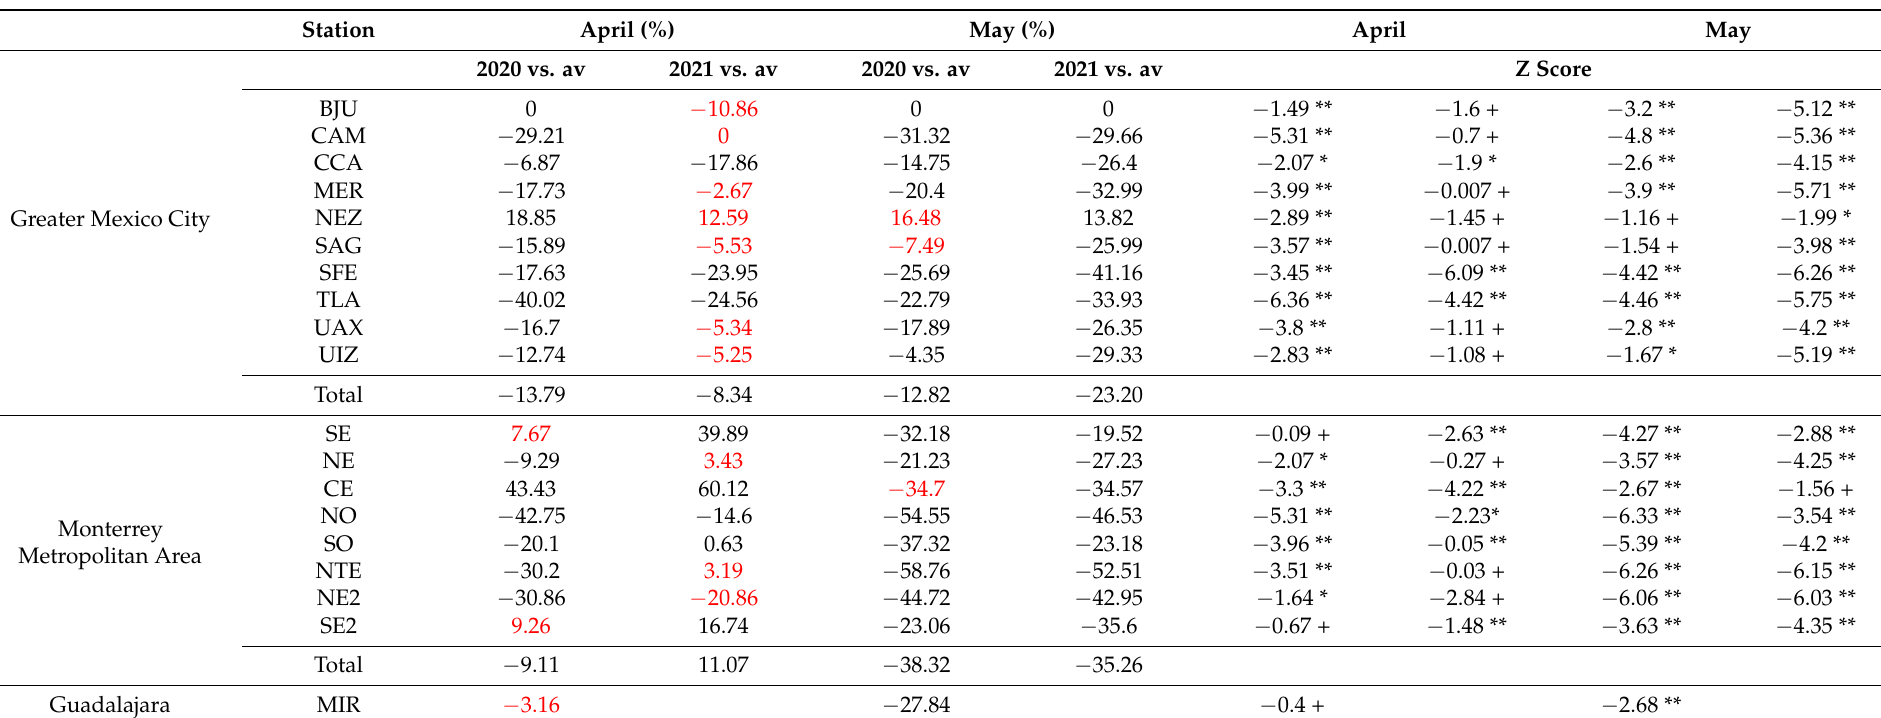
Table 3. PM 2.5 concentration changes in GMC, MTY, and MAG ( p < 0.05 significance level). Numbers in red indicate no statistically significant change